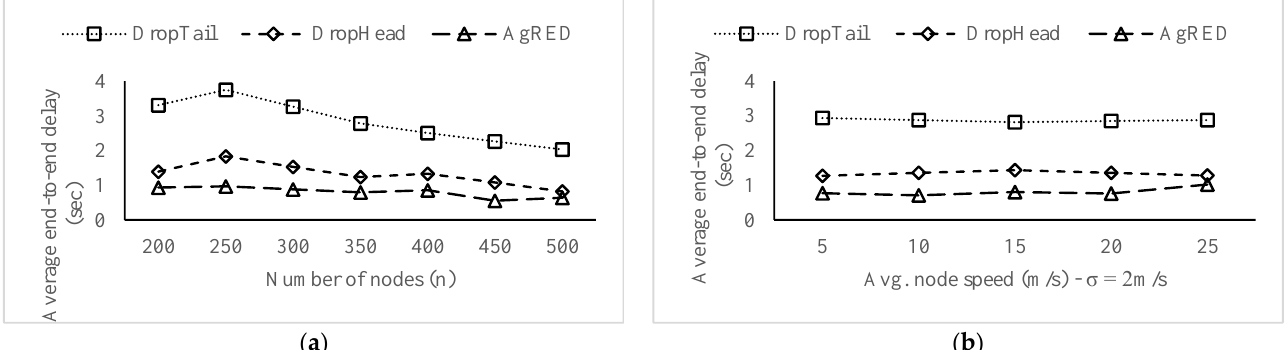
Figure 15. Average end-to-end delay (UDP) for Drop-tail, Drop-head and AgRED with ( a ) varying number of nodes and ( b ) varying speed.